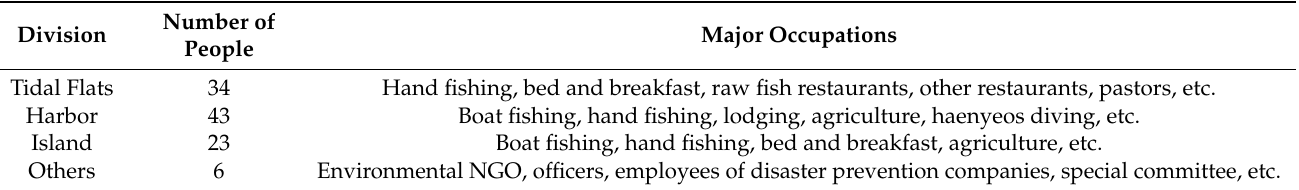
Table 1. Major economic activities of affected residents who participated in the in-depth interviews.